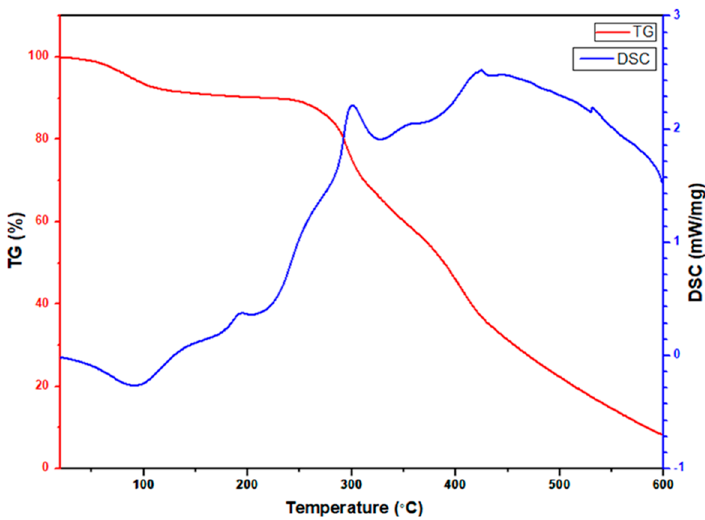
Figure 9. TGA/DSC studies of electrospun CeO 2 -CuCrO 2 nanofibers.